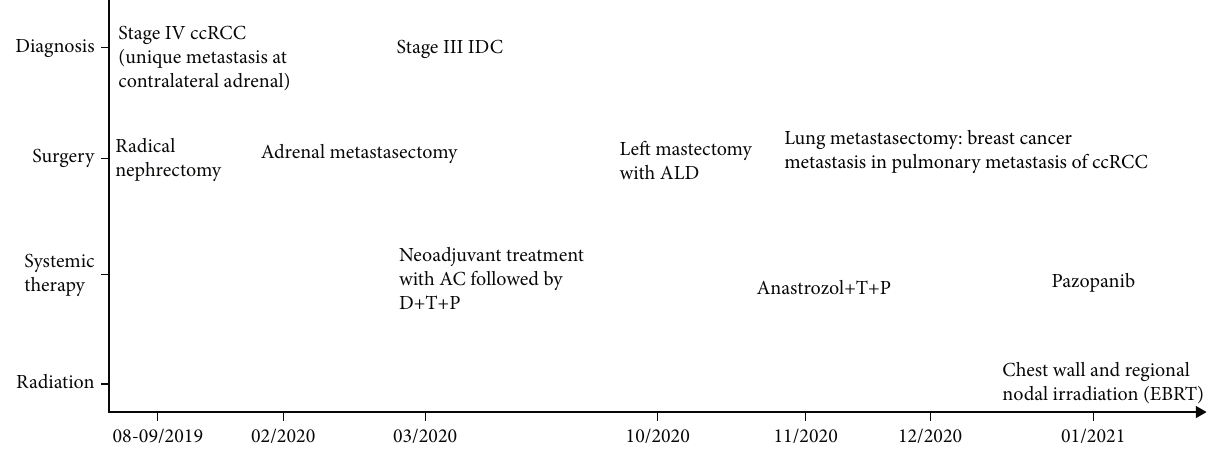
Figure 6: Overview of the patient clinical history and management. Table 1: Clinical cases of breast carcinoma to renal cell carcinoma tumor-to-tumor metastasis described in the literature. Gender Age